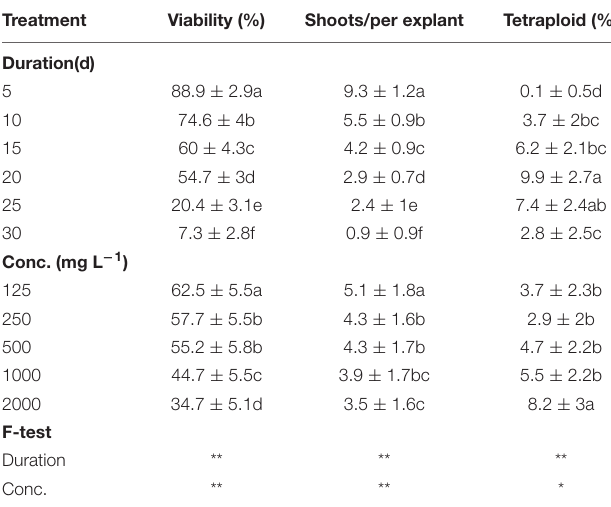
TABLE 1 | Main effect of colchicine concentration and duration on viability of explants, shoot regeneration, and tetraploid induction rate from garlic inflorescence on solid